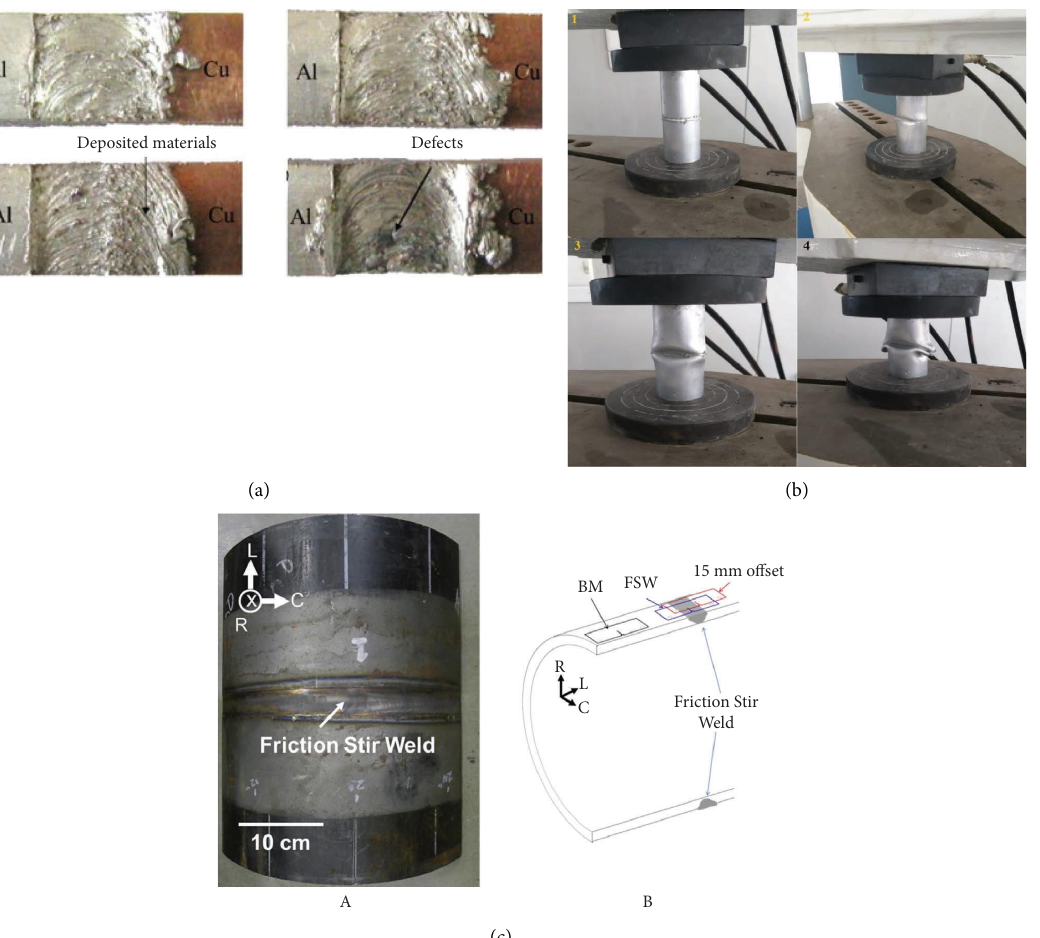
Figure 8: FSW aluminium alloy pipes. (a) Dissimilar pipes [114], (b) crash test of FSWed AA 6063 pipes [113], and (c) steel pipes